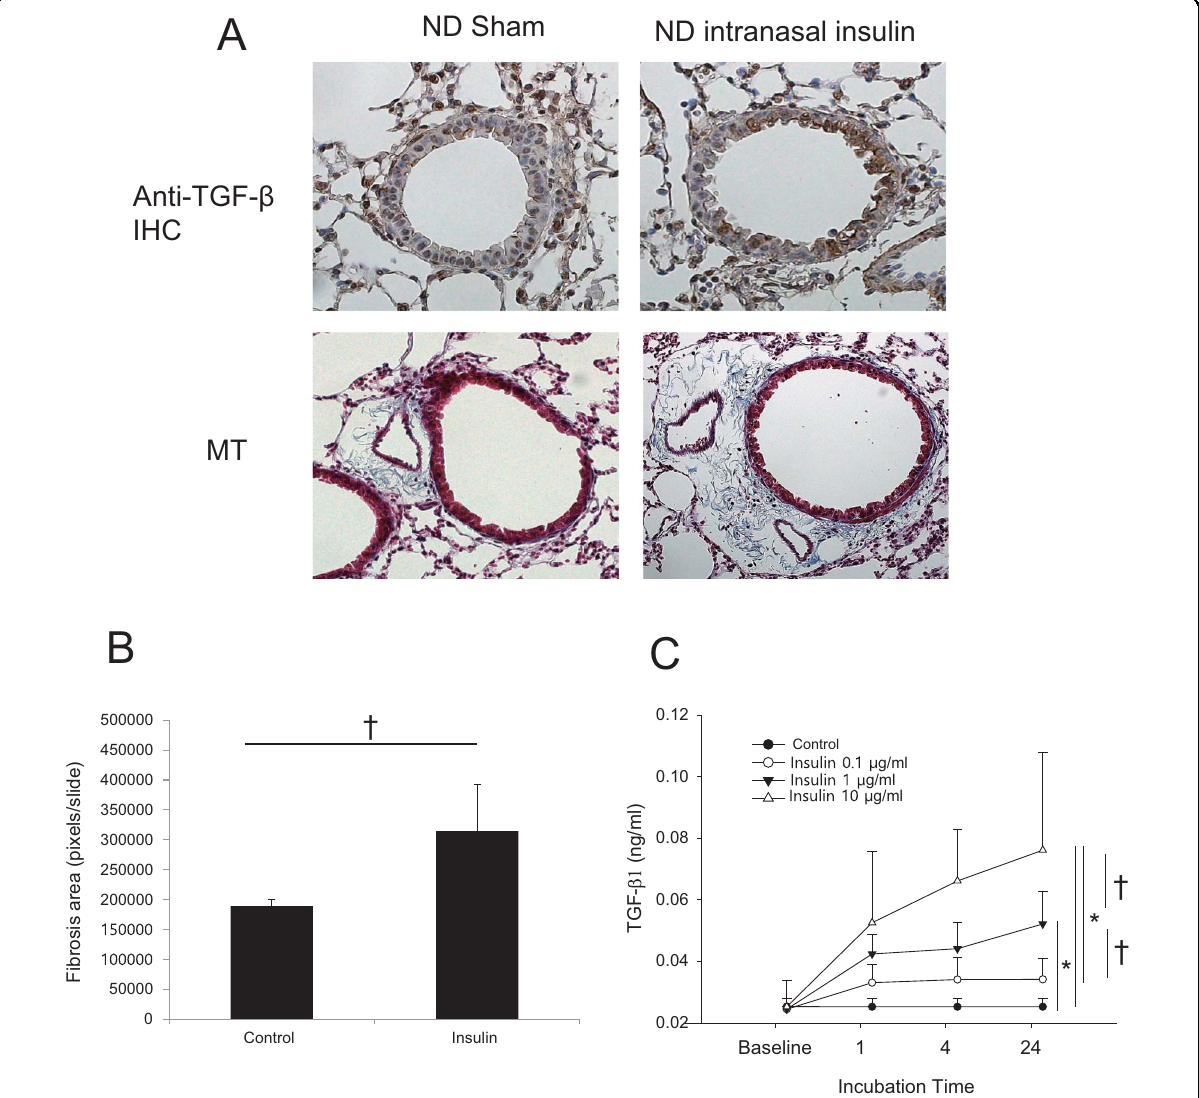
Fig. 7 Anti-TGF- β 1 immunohistochemical staining and Masson ’ s trichrome staining after repeated intranasal inoculations of insulin. Panel a is shown at ×200 magni fi cation. The quanti fi cation of the lung fi brosis score calculated using Masson ’ s trichrome staining measured by Metamorph ® software ( b ) is also shown. The expression of TGF- β 1 by BEAS-2B cells was dose-dependently increased by different concentrations of insulin for different incubation times ( c ). TGF transforming growth factor. † P < 0.05, * P <